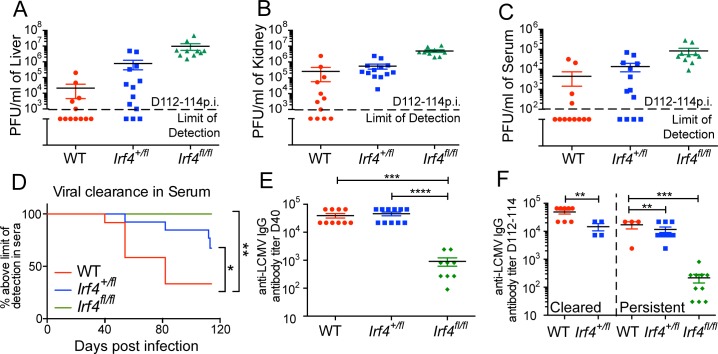
High expression of IRF4 is essential for long-term control of LCMV-clone 13.Kidney (A), livers (B) and sera (C) were harvested from LCMV-clone 13 infected WT, Irf4
+/fl and Irf4
fl/fl mice between D112-114 post-infection and virus titers were determined by plaque assay. Dotted line indicates the limit of detection. Each data point represents an individual mouse and data are a compilation of three independent experiments. (D) Serum was harvested from infected mice at various timepoints post-infection. Graph indicates the proportion of mice with viral titers above the limit of detection over time. Data are a compilation of three independent experiments; significant differences were determined by Log-rank (Mantel-Cox) test. (E) Anti-LCMV IgG antibody titers in sera at D40 p.i. Each data point represents an individual mouse and data are a compilation of three independent experiments; significant differences determined by Ordinary one-way ANOVA using Tukey’s multiple comparison test. (F) Anti-LCMV IgG antibody titers in sera at D112-114 p.i. Data are segregated based on serum viral titers; at left are mice with undetectable virus in their sera (cleared) and at right are mice with persistent serum virus titers (persistent). Each data point represents an individual mouse and data are a compilation of three independent experiments; significant differences determined by unpaired t test with Welch’s correction (cleared) and Ordinary one-way ANOVA using Tukey’s multiple comparison test (persistent).